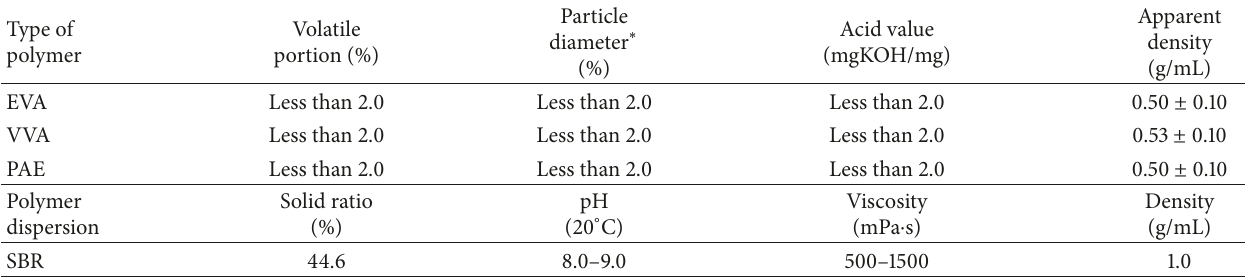
Table 1: Physical properties of